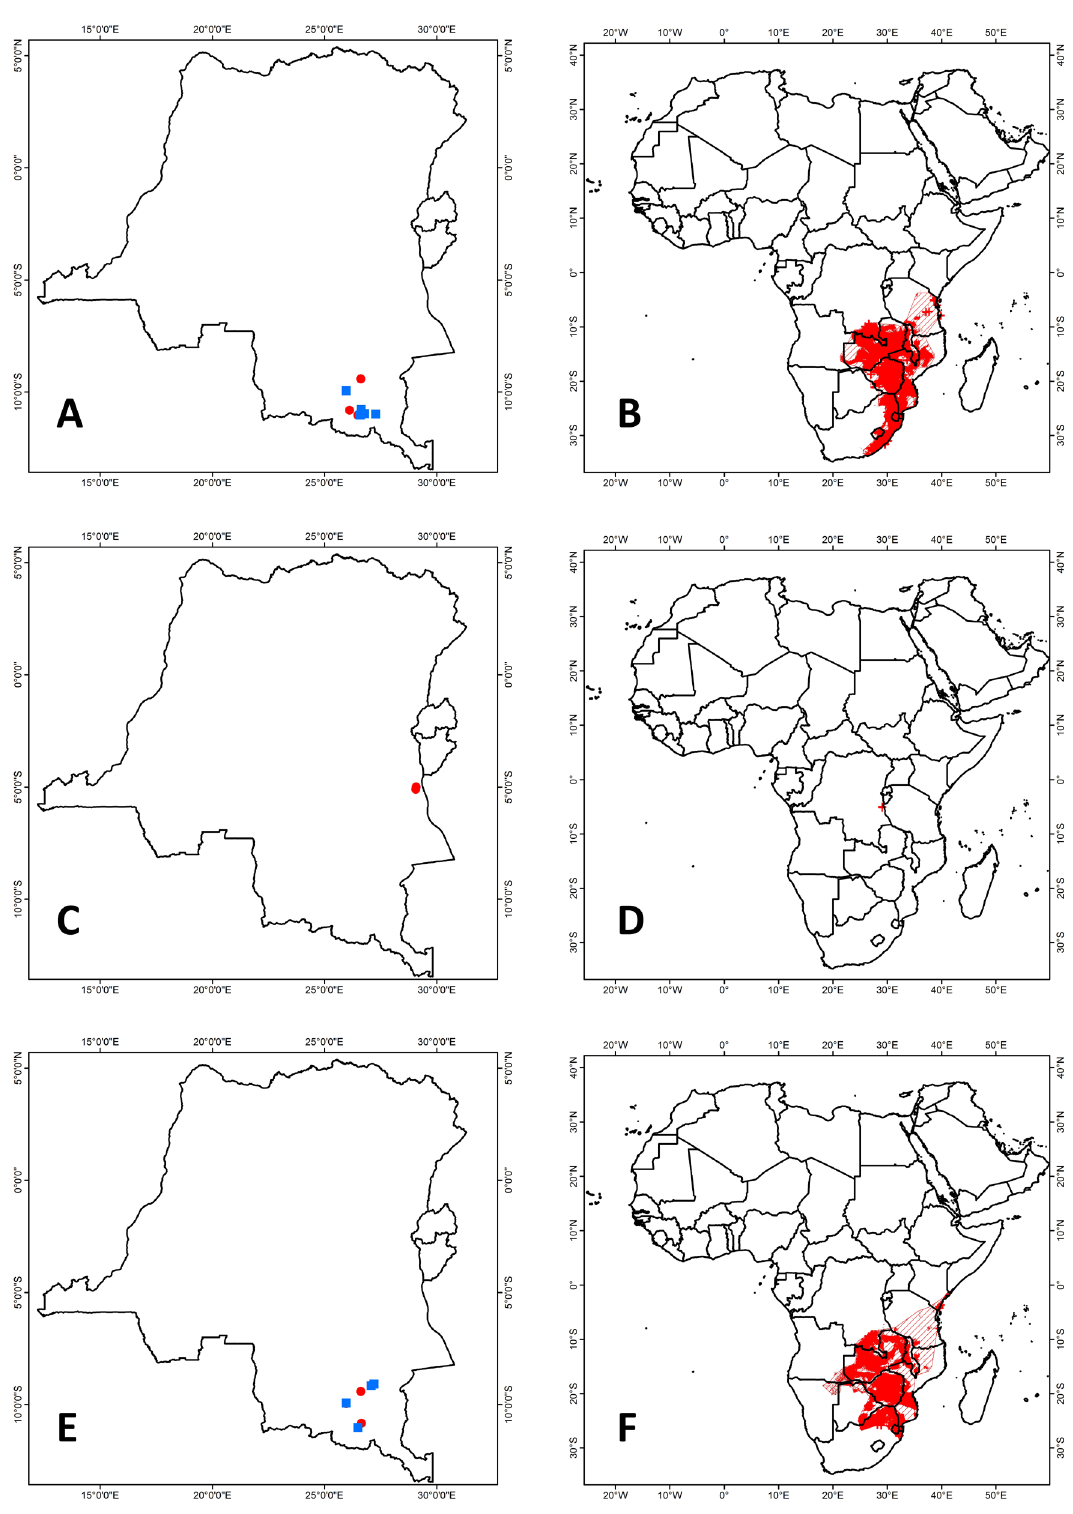
Fig. 18. Distribution maps. A–B . Rhinolophus swinnyi Gough, 1908. C–D . Rhinolophus willardi